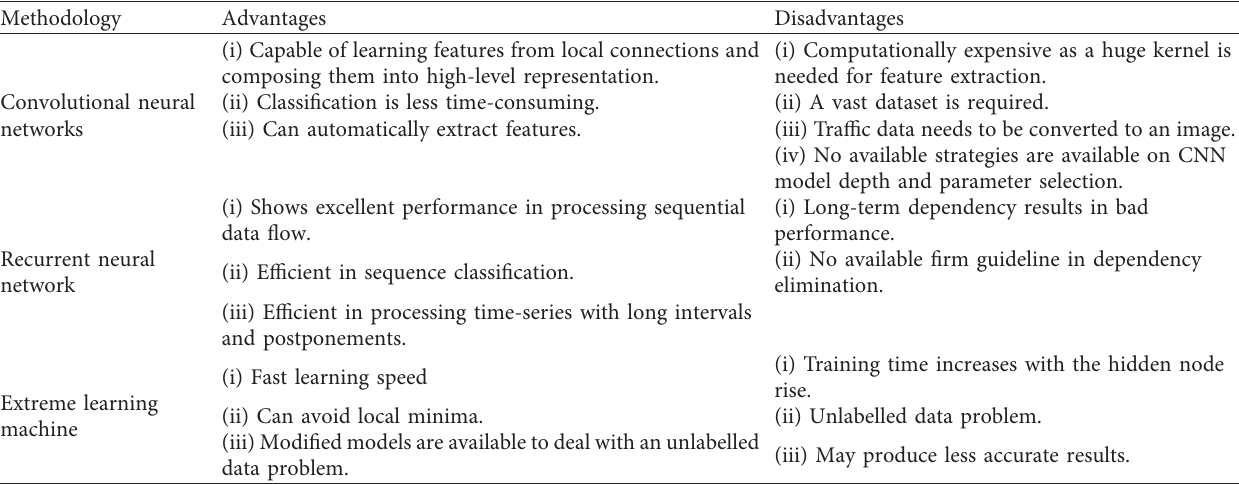
Table 6: The strength and weakness of the models of deep machine